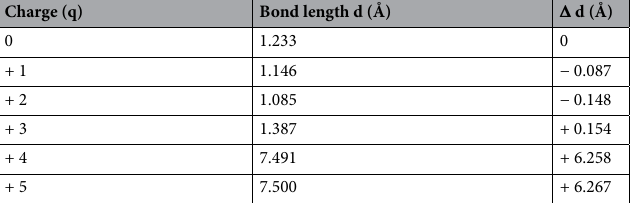
Table 1. The effect of electron removal in the bond length (d) of O 2 molecule. The charge state (q) refers to the number of electron removed from the neutral system. Thus, q = 1 refers to 1.60217662 × 10 per